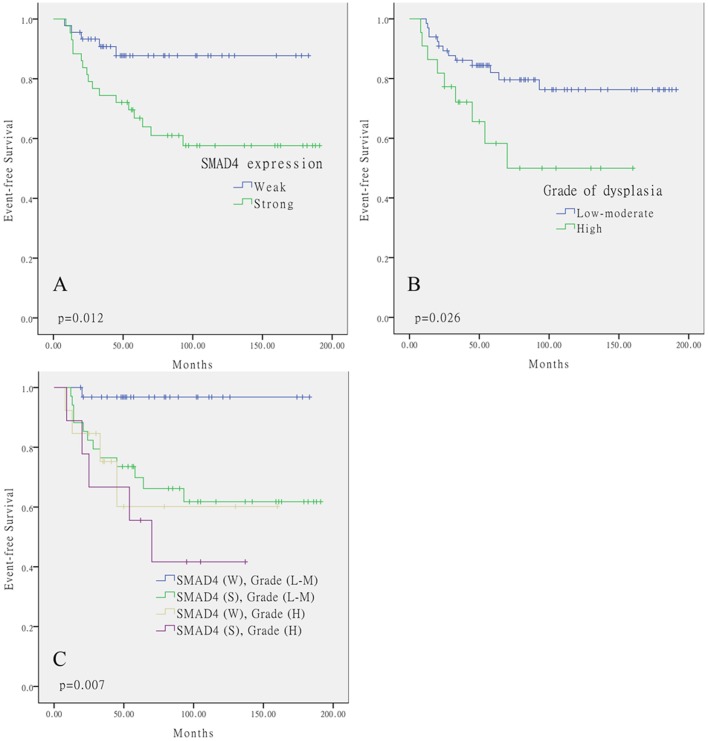
Kaplan–Meier analysis showed that A, Stronger expression of SMAD4 was associated with higher OL malignant transformed rate (p = 0.012, log-rank test); B, High-grade of dysplasia was associated with higher OL malignant transformed rate (p = 0.026, log-rank test).C, The combination of strong SMAD4 expression and high grade of dysplasia predicted the malignant transformation of oral leukoplakia better than either single factor did (p = 0.007, log-rank test).